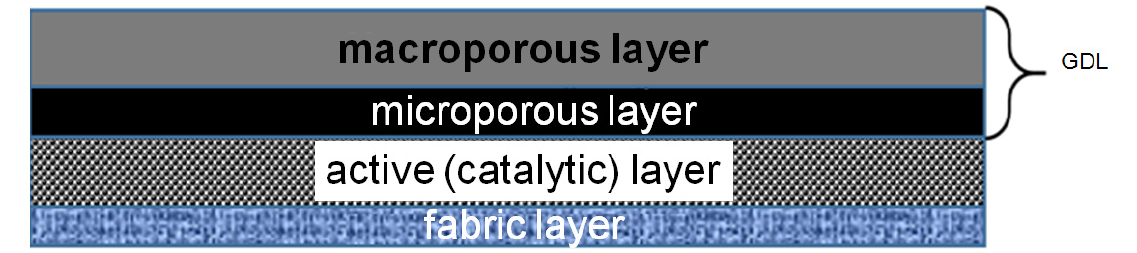
Figure 2. Scheme of the anode structure based on GDL and BM.